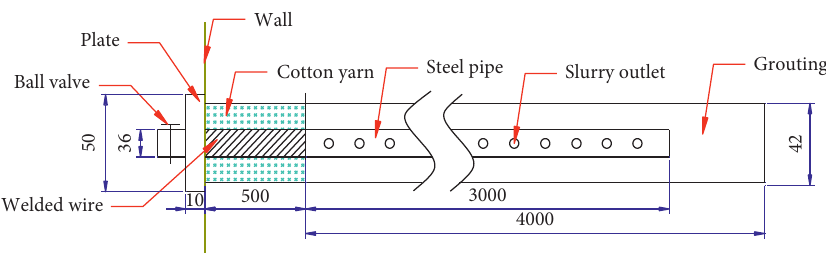
Figure 7: The schematic diagram of grouting pipe design.